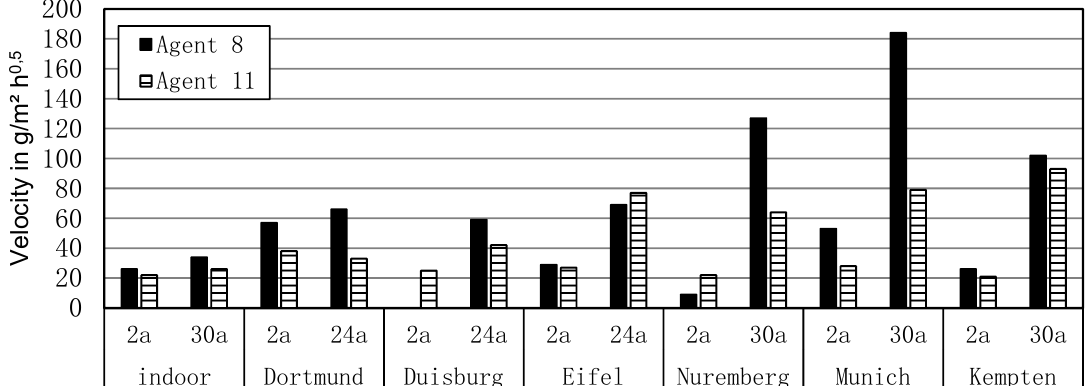
Figure 11. Velocity of water uptake between 5 and 120 min for OKS treated with agent 8 and 11 and weathered at the 7 different locations.